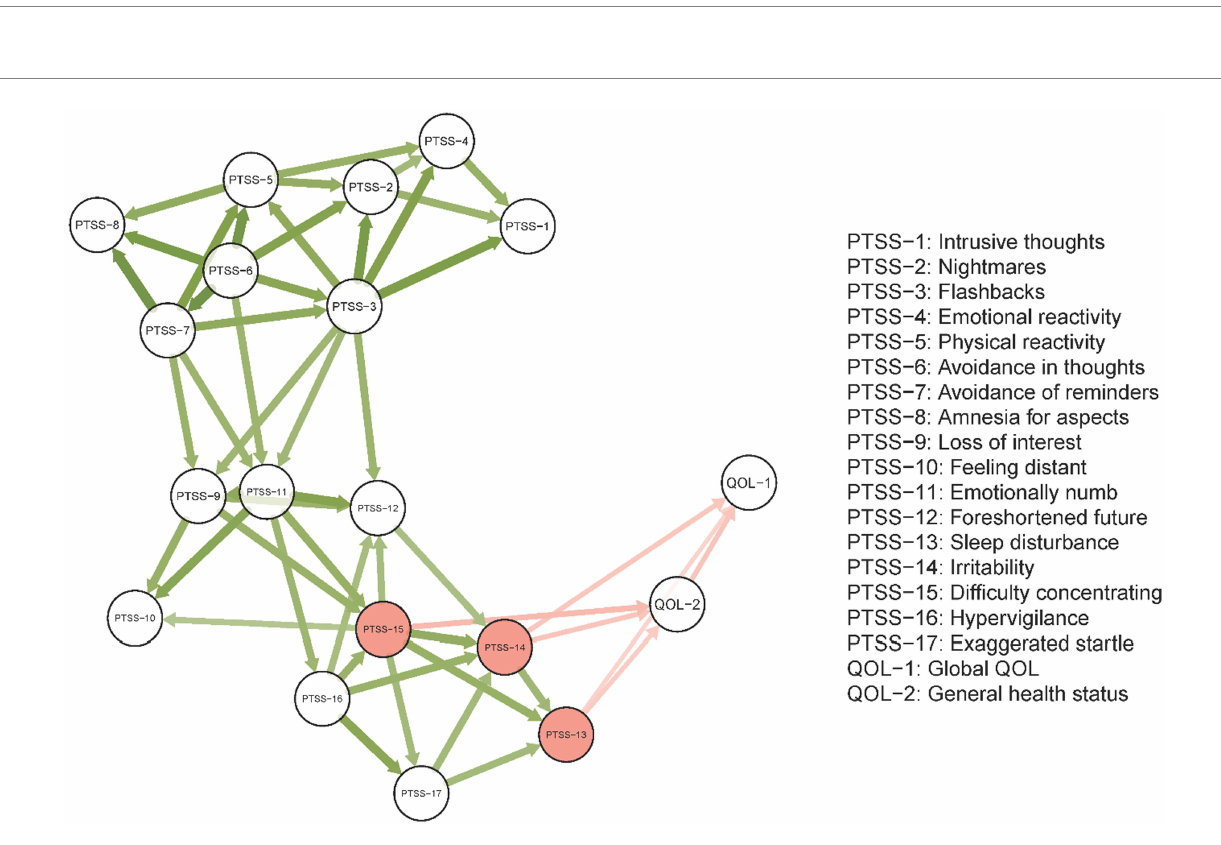
FIGURE 3 Directed network model of the PCL-C and QOL estimated by the Triangulated Maximally Filtered Graph (TMFG) method. Edge thickness indicates edge weight. Red nodes have the highest bridge strength in the undirected network. Arrows indicate the direction of influence. Defining the two-way influences between node i and node j as D( i, j ) and D( j, i ), only the greater link between D( i, j ) and D( j, i ) is